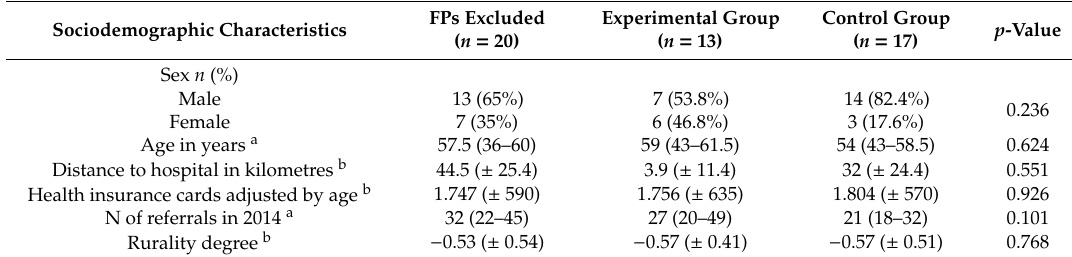
Table 1. Sociodemographic characteristics of the included and excluded family physicians (FPs) by groups.